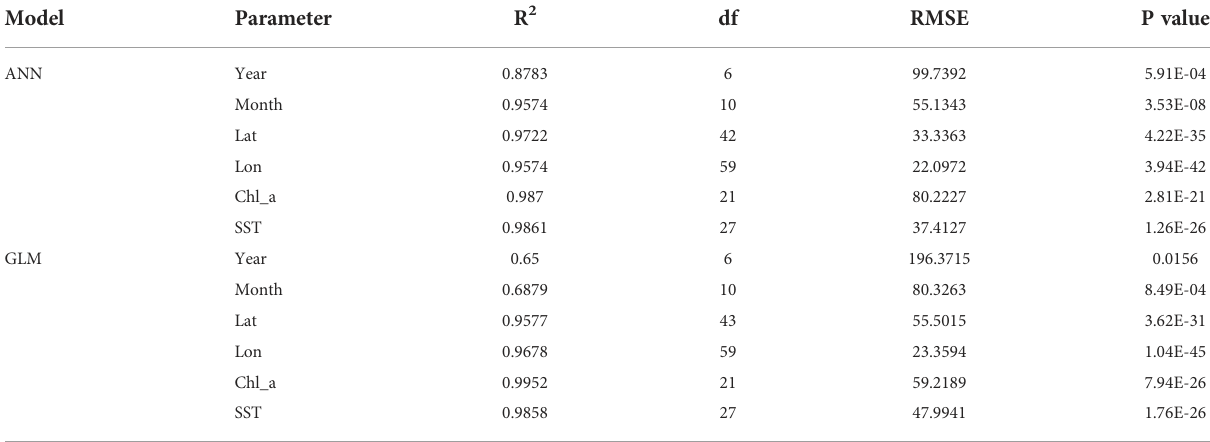
TABLE 1 Statistical analysis results of nominal CPUE and CPUE predicted by